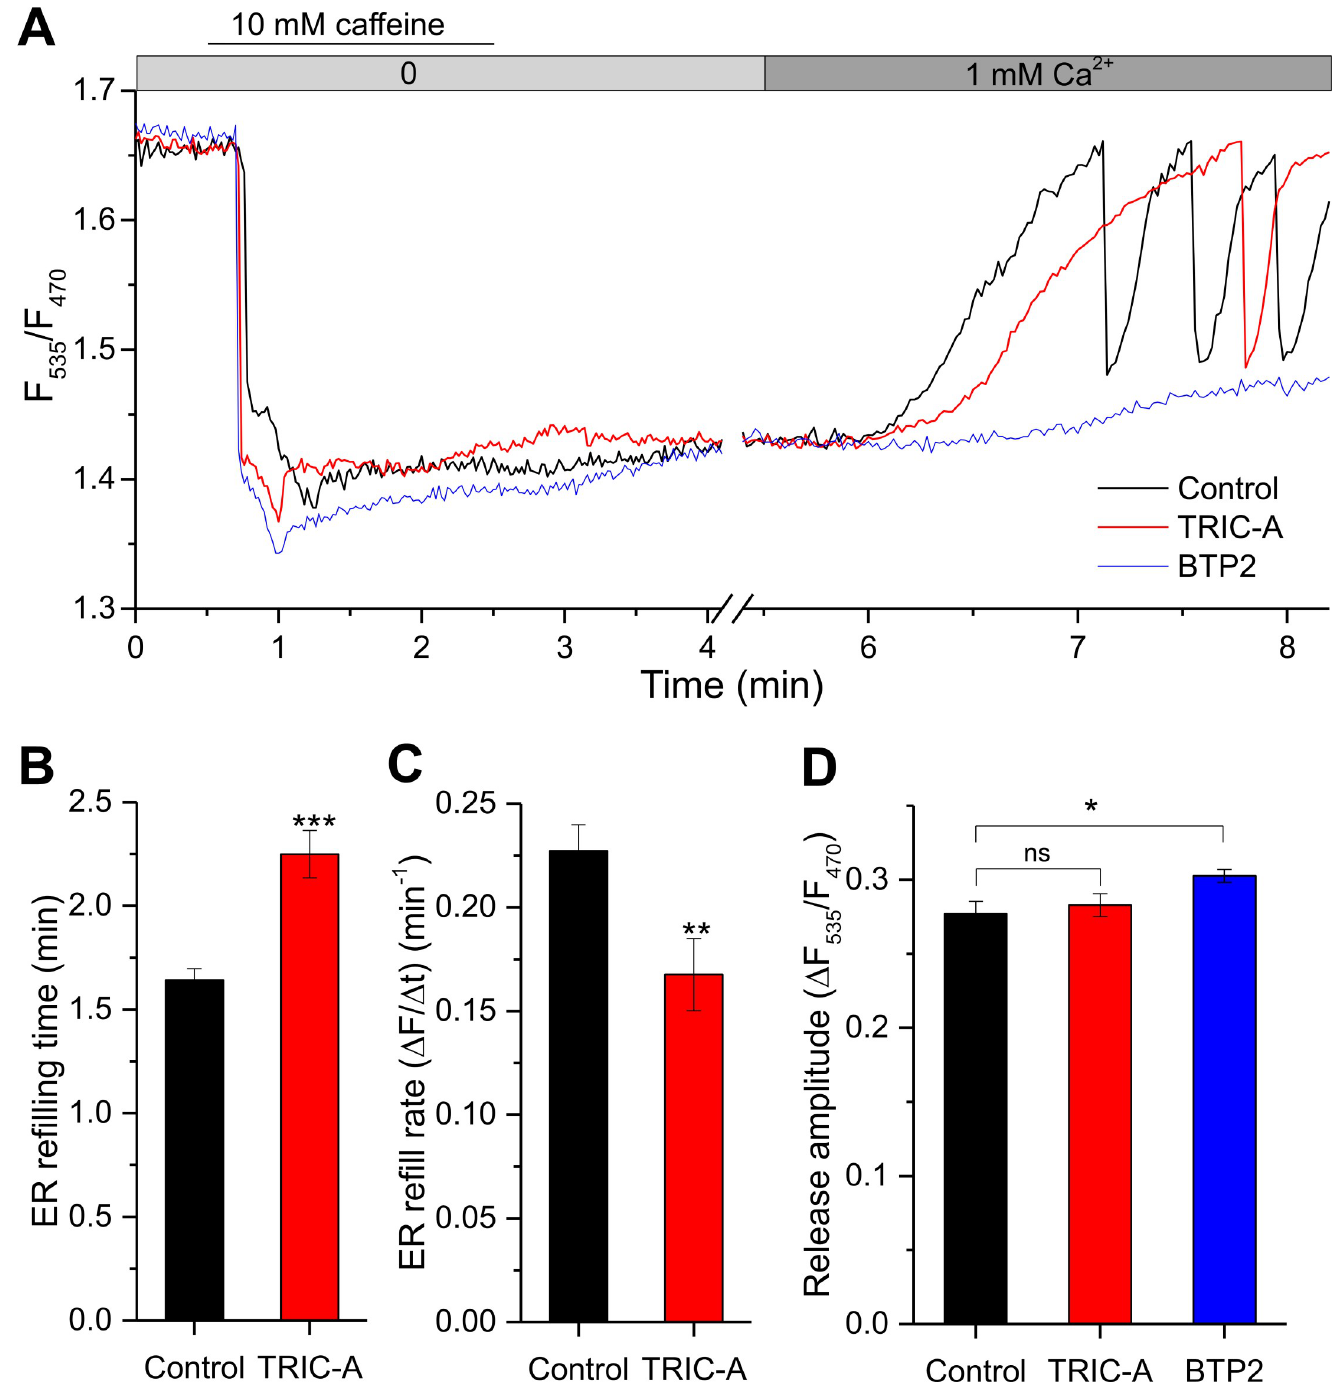
Fig 3. TRIC-A delays cyclic Ca 2+ refilling upon store depletion. (A) [Ca 2+ ] ER -sensitive D1ER traces representing ER Ca 2+ depletion with 10 mM caffeine, followed by ER refilling upon 1 mM [Ca 2+ ] o addition in an mCherry-ER-3– (control, black) or TRIC-A-mCherry (TRIC-A, red)–transfected HEK293_RyR2 cell or diminished refilling in a 3 μ M BTP2-incubated control cell (BTP2, blue). Bar graphs show mean ± SEM values for (B) ER refilling time and (C) ER refill rate in TRIC-A (+) cells ( n = 45) versus controls ( n = 51), and (D) ER Ca 2+ release peak amplitude in TRIC-A (+) cells ( n = 45) and BTP2-incubated cells ( n = 36) versus controls ( n = 51); � p < 0.05, �� p < 0.01, ��� p < 0.001. Underlying data in panels (A–D) are included in S1 Data. BTP2, N-[4-[3,5-Bis(trifluoromethyl)pyrazol-1-yl]phenyl]- 4-methylthiadiazole-5-carboxamide; D1ER, genetically encoded ER-targeted Ca 2+ sensor; ER, endoplasmic reticulum; HEK293, human embryonic kidney 293; ns, nonsignificant; RyR, ryanodine receptor; TRIC, trimeric intracellular cation.